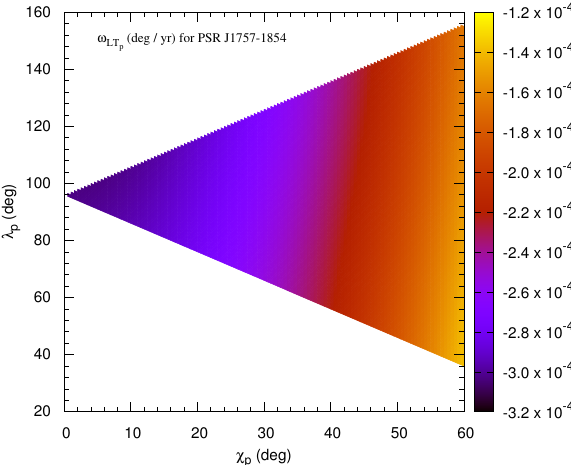
Figure 2. Variation of ˙ ω LT with χ p (in degrees) along the horizontal axis and λ p (in degrees) along the p vertical axis for PSR J1757 − 1854. The color code represents values of ˙ ω LT